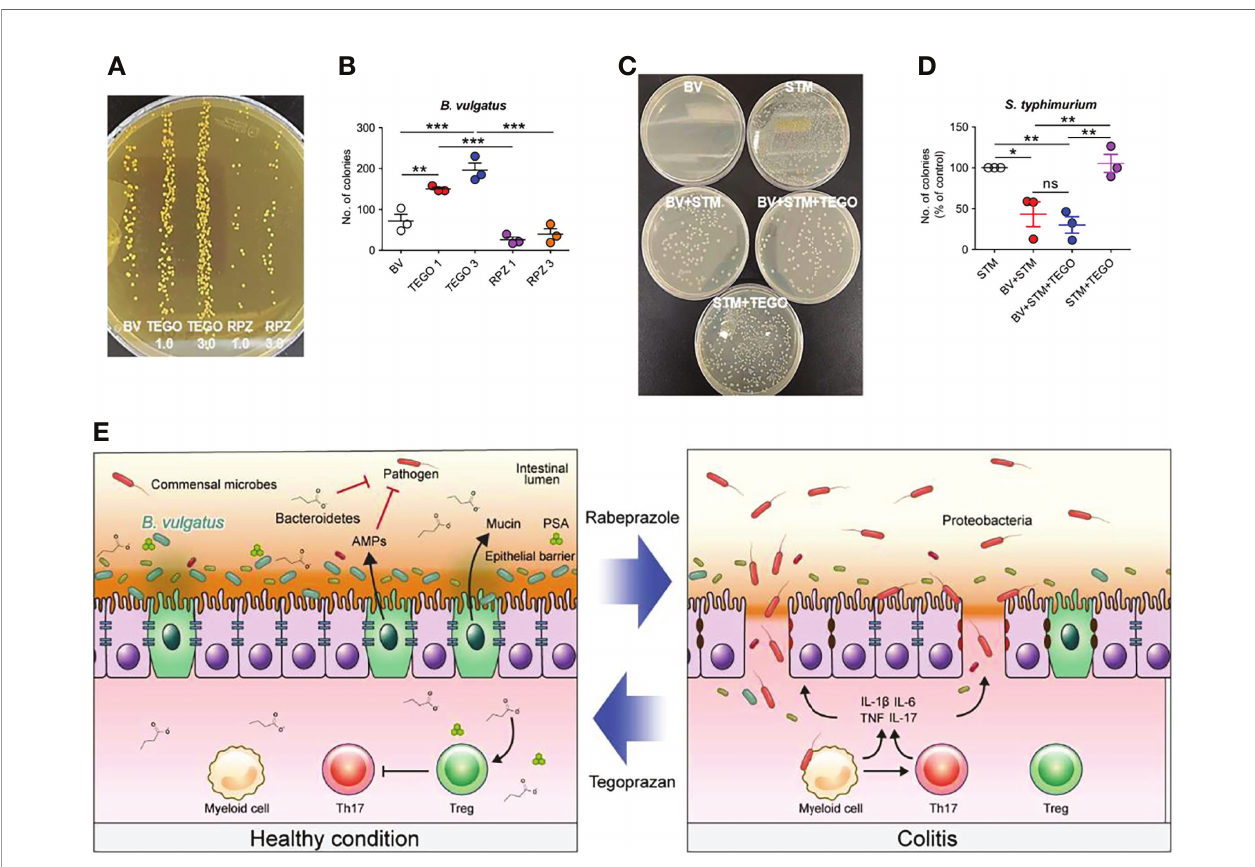
FIGURE 6 | Tegoprazan inhibits epithelial adhesion of pathogenic bacteria by directly promoting the growth of Bacteroides vulgatus . (A, B) Effect of tegoprazan on the growth of B vulgatus. Data represent the mean ± standard error of the mean (S.E.M) of 4 independent experiments. (A) Representative image of B vulgatus growth treated with tegoprazan and rabeprazole. (B) Quanti fi cation of B vulgatus plated on GAM agar plate, plotted as the number of colonies. (C, D) Effect of B vulgatus on the attachment of pathogenic bacteria to epithelial cells. Data represent the mean ± standard error of the mean (S.E.M) of 3 independent experiments. (C) Representative images of adhered Salmonella typhimurium colonies. (D) Quanti fi cation of S. typhimurium plated on nutrient agar plate, plotted as percdentage of control. (E) Graphical summary. Signi fi cance is indicated by * p < 0.05, ** p < 0.01, and *** p < 0.001 using one-way ANOVA followed by Dunnett ’ s multiple comparison test. ns, not signi fi cant; BV, B vulgatus only; TEGO 1, treated with 1.0 m M tegoprazan; TEGO 3, treated with 3.0 m M tegoprazan; RPZ 1, treated with 1.0 m M rabeprazole; RPZ 3, treated with 3.0 m M rabeprazole; STM, S. Typhimurium only, BV+STM, S. Typhimurium treated with B vulgatus ; BV+STM+TEGO, S. Typhimurium treated with B vulgatus and tegoprazan; STM+TEGO, S. Typhimurium treated with tegoprazan; GAM, Gifu anaerobic